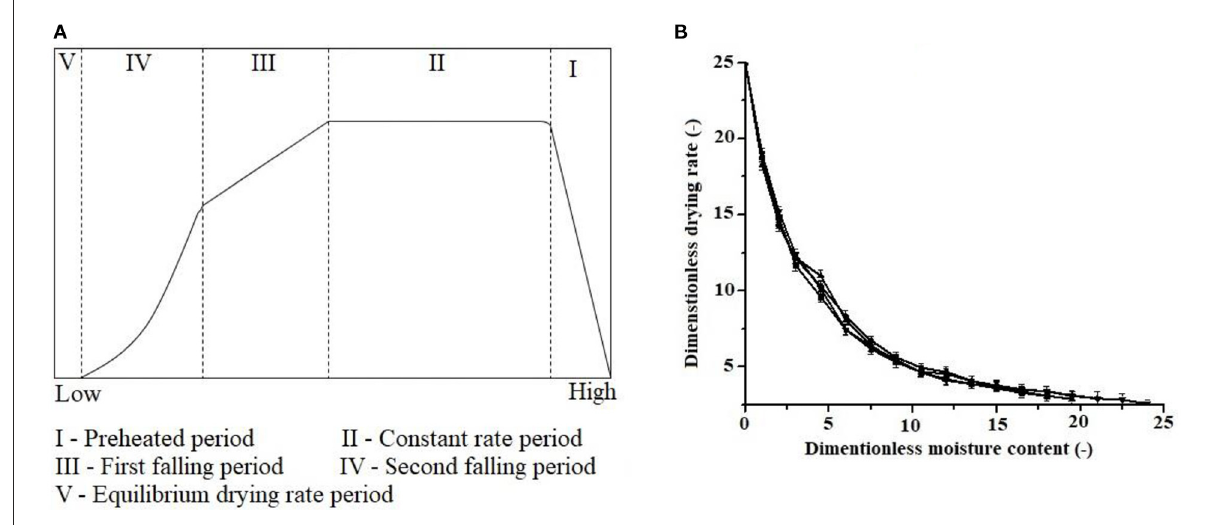
FIGURE2 (A) Typical stages of food product drying, (B) drying curve of sweet potatoes.